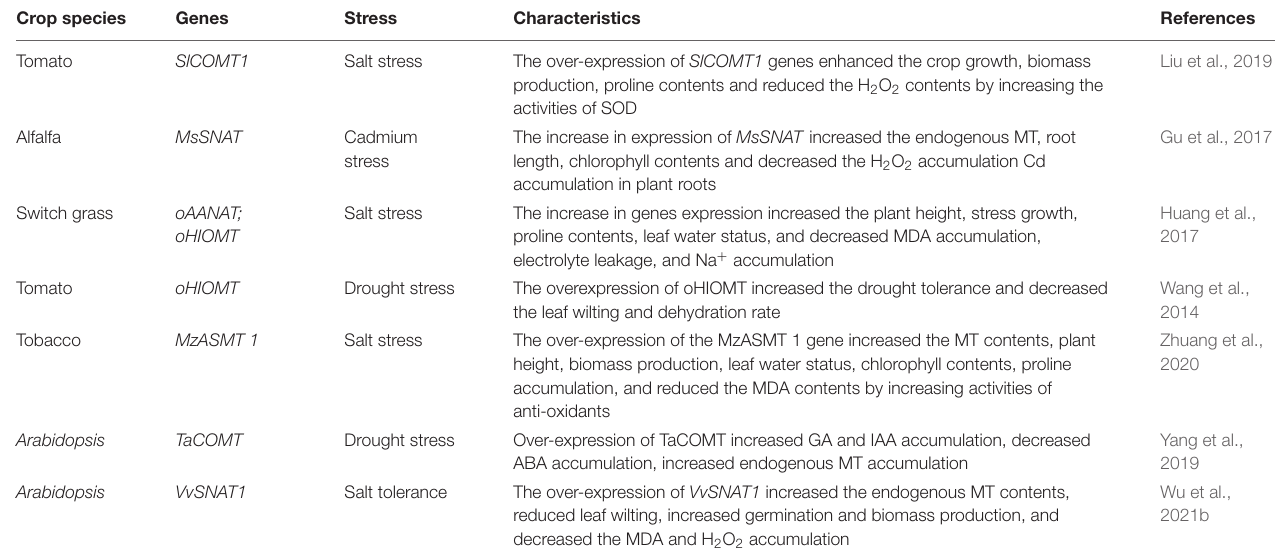
TABLE 7 | Role of melatonin in inducing stress tolerance in transgenic plant species. Crop species Genes